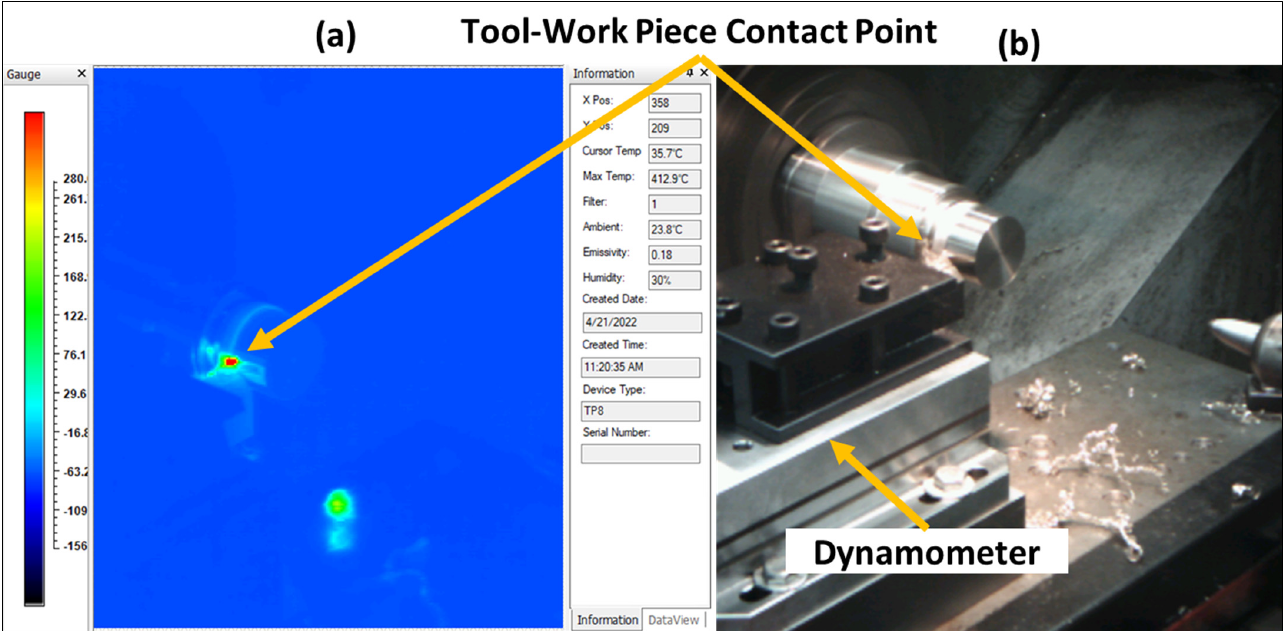
Figure 4. Temperature monitoring by ThermoPro-TP8 at v c = 80 m/min, a p = 0.5 mm, and f r = 0.045 mm/rev. ( a ) The temperature contour view by the thermo camera. ( b ) The real cutting views. A surface-tester-type Rugosurf 90-G, from Tesa (Bugnon, Switzerland) was used to measure the surface roughness, Ra. The settings of measurement parameters are cutoff length of 0.8 mm and measuring speed of 1 mm/s, as shown in Figure 5.